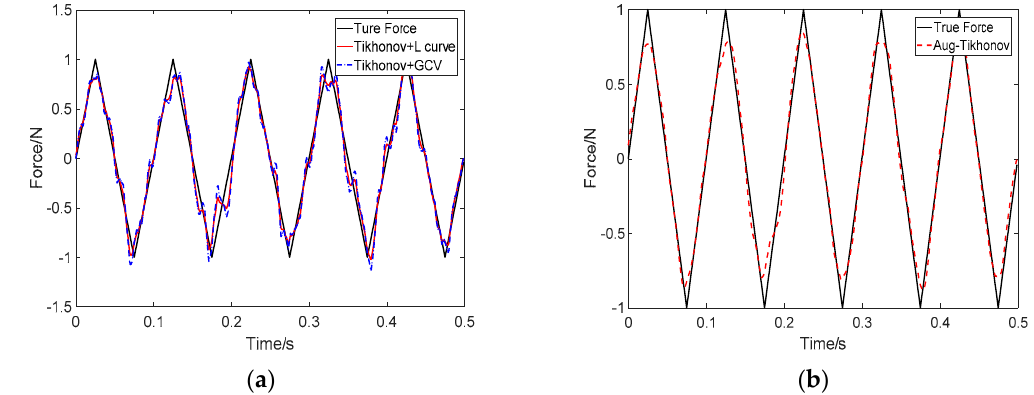
Figure 10. Identification result of triangle wave load at SNR 20 dB: ( a ) Tikhonov method; ( b ) the proposed method.